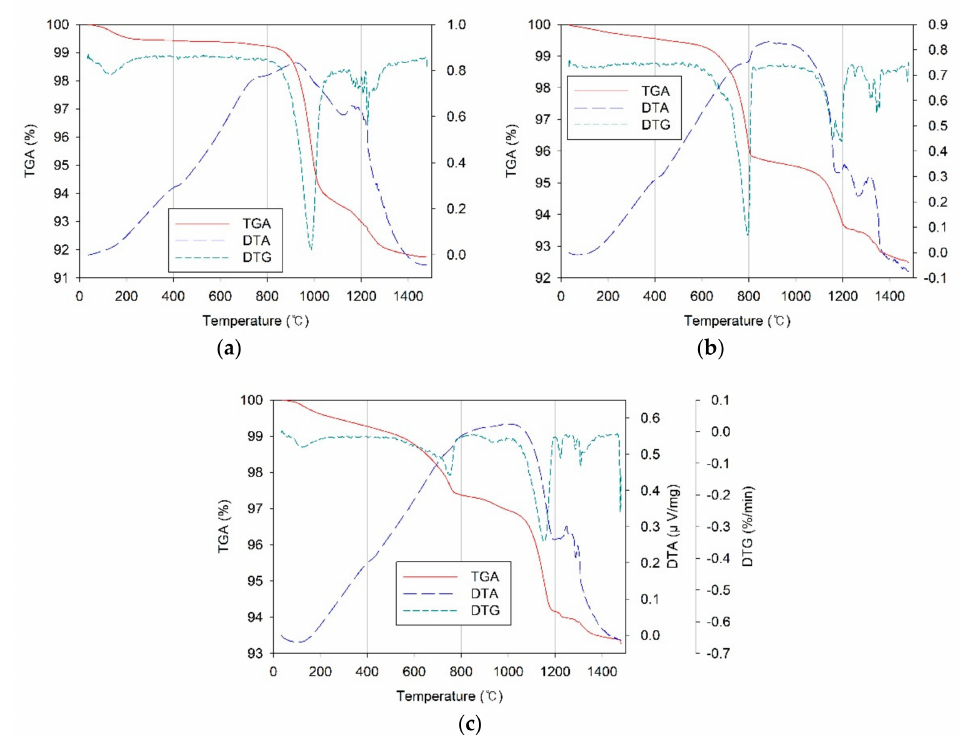
Figure 8. Results of thermo-gravimetric analysis (TGA)—differential thermal analysis (DTA), deriva- tive thermo gravimetry(DTG): ( a ) sewage sludge, ( b ) sawdust, ( c ) sludge solid